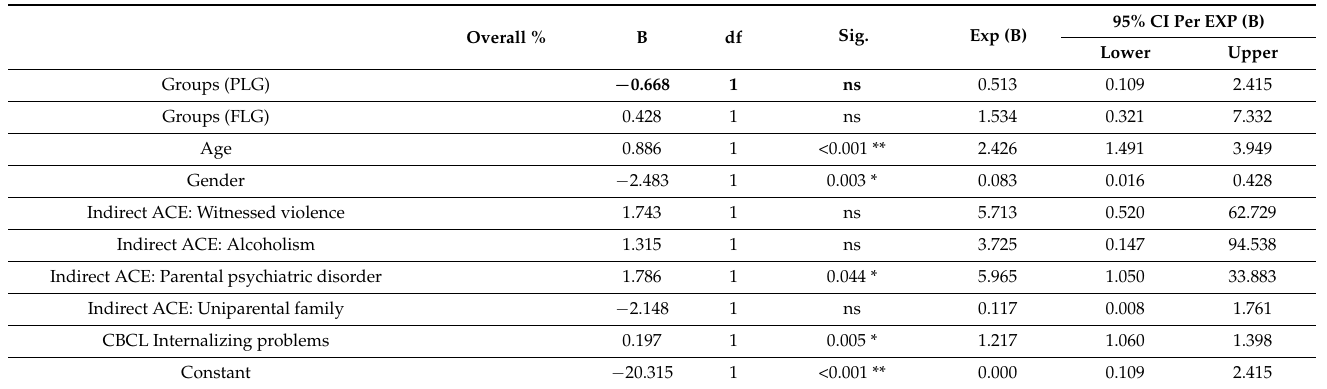
Table 4. Multiple linear